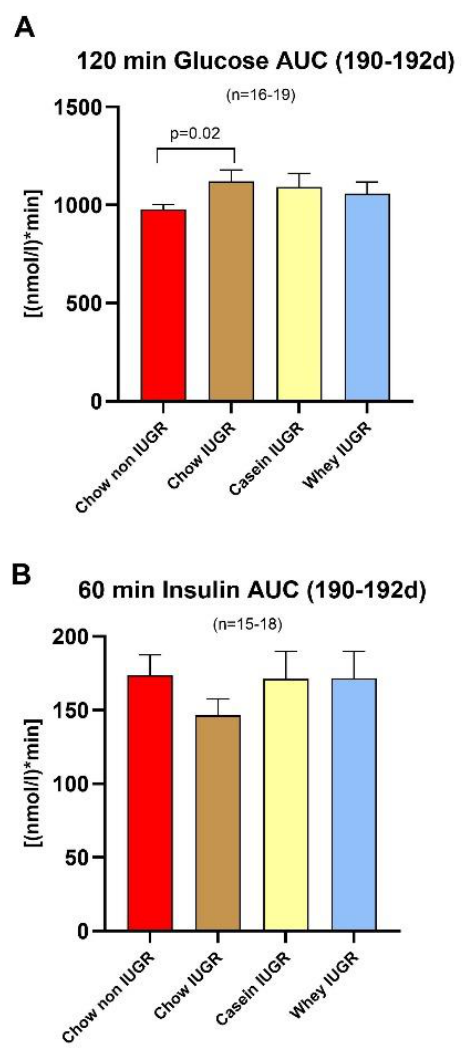
Figure 5. Glucose and Insulin Area under the Curve (AUC). ( A ) 120 min glucose AUC 190–192d and ( B ) 60 min Insulin AUC 190–192d; n = 16–19 per group for glucose and n = 15–18; values are median ± SE